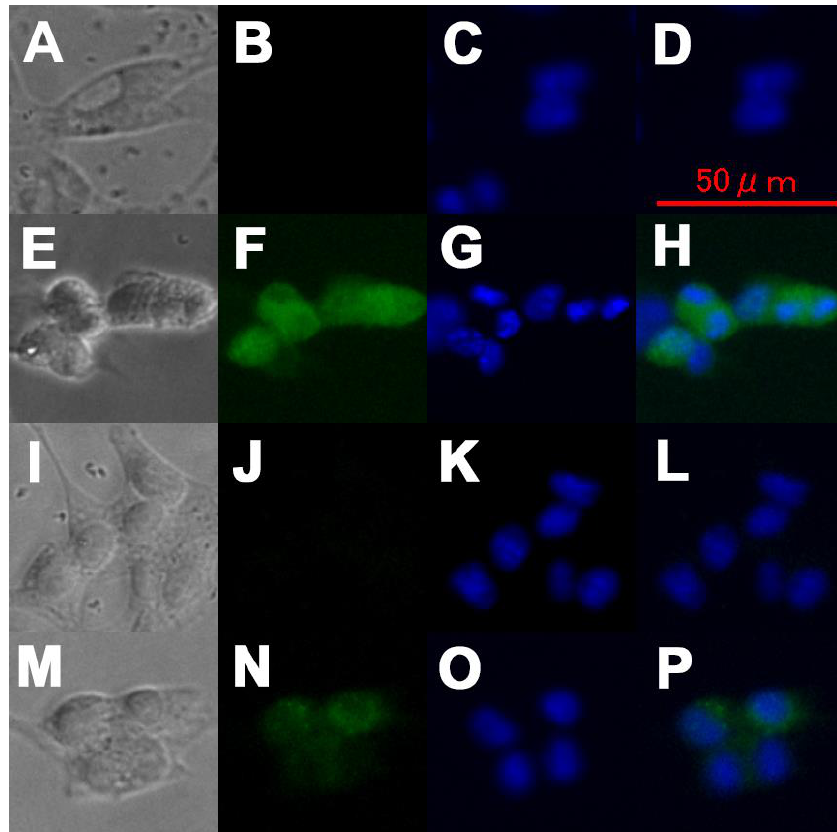
Figure 2. The micro-distribution of each boron compound in F98 rat glioma cells. ( A , E , I and M ) A phase-contrast micrograph of F98 cells that were cultured in DMEM ( A ), containing BPA ( E ), BSH ( I ), and KA-BSH (M). ( B , F , J and N ) A fluorescence micrograph of F98 cells that were cultured in DMEM ( B ), containing BPA ( F ), BSH ( J ), KA-BSH ( N ) stained with the anti-BSH antibody A9H3 ( B , J and N ), or anti-BPA antibody 2B10 ( F ). ( C , G , K and O ) A fluorescence micrograph of F98 cells that were cultured in DMEM ( C ), containing BPA ( G ), BSH ( K ), and KA-BSH ( O ) stained with Hoechst 33342. ( D , H , L and P ) Merged images. B and C ( D ), F and G ( H ), J and K ( L ), N and O ( P ).